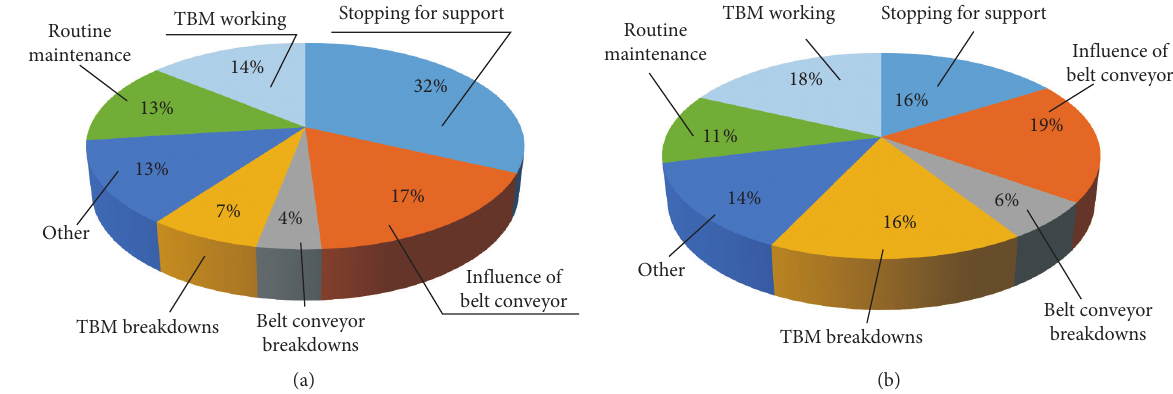
Figure 12: Time distribution chart of TBM construction: (a) 1 # diversion tunnel and (b) 3 # diversion